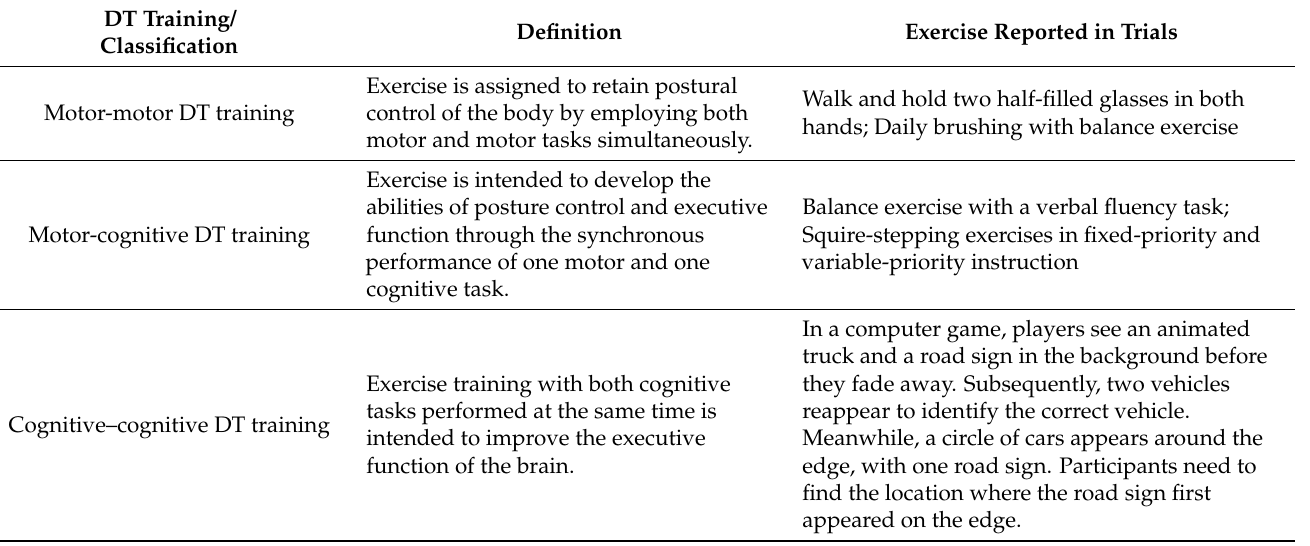
Table 1. Dual-task training classification, definitions, and examples of